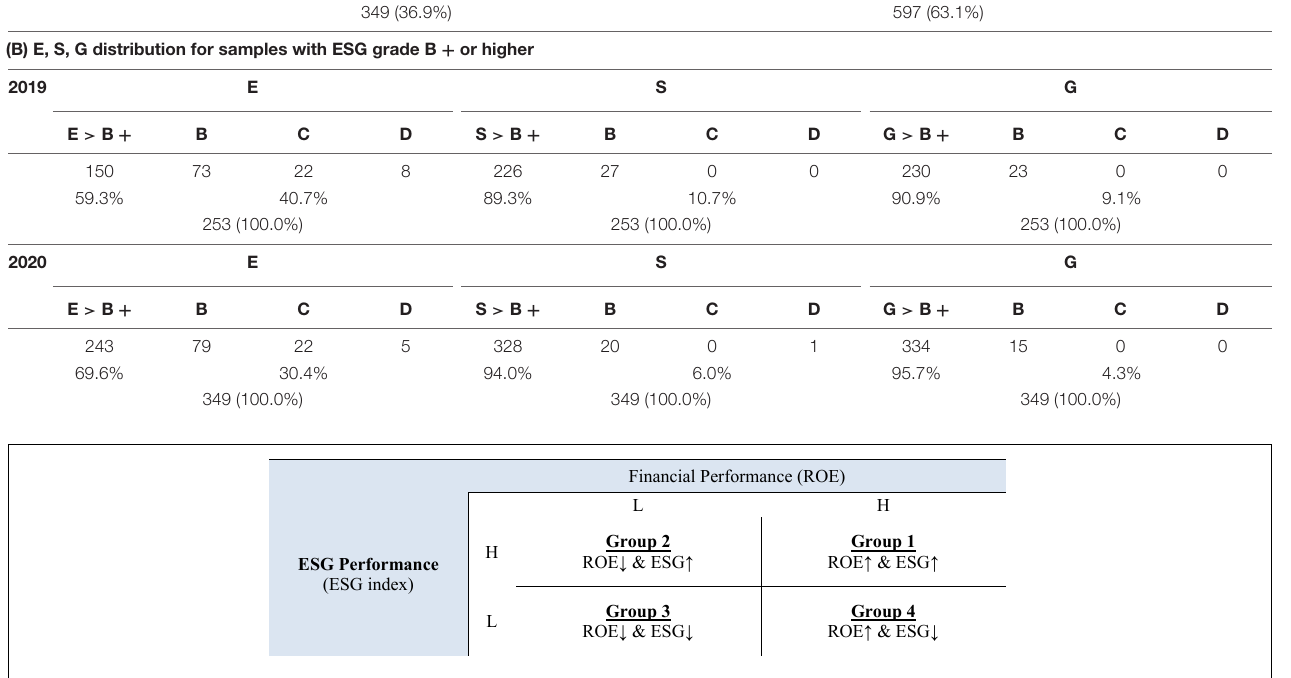
FIGURE 1 | Group classification by financial performance [return on equity (ROE)] and environment, social, and governance (ESG) performance.